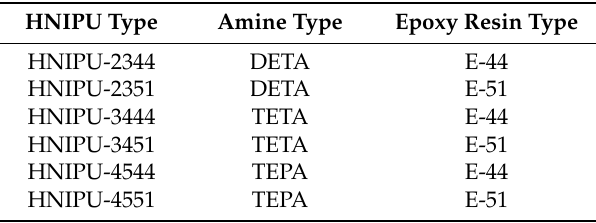
Table 1. The raw materials of Table1. The raw materials of HNIPUs. Table1. The raw materials of HNIPUs.